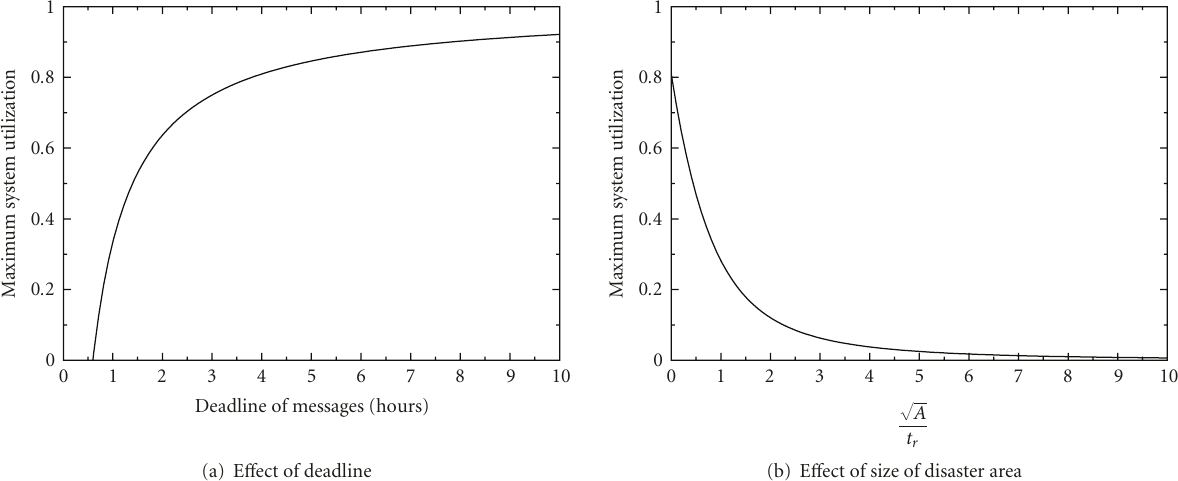
Figure 5: E ff ects of parameters on maximum throughput.